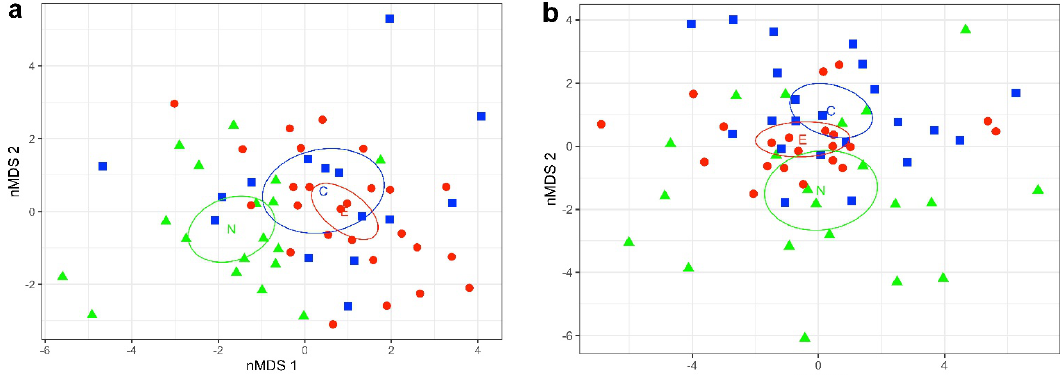
Figure 3. Sepia typica nMDS plots of morphometric measurement residuals by area for ( a ) females and ( b ) male. Symbols denote sampling area: Northwest ( green triangles ); Central ( blue squares ); Eastern ( red dots ). Alpha characters denote the centre of distribution per area (C = Central, E = Eastern, and N = Northwest Areas) and the ellipses indicate the 95% confidence interval about the cen- troids.